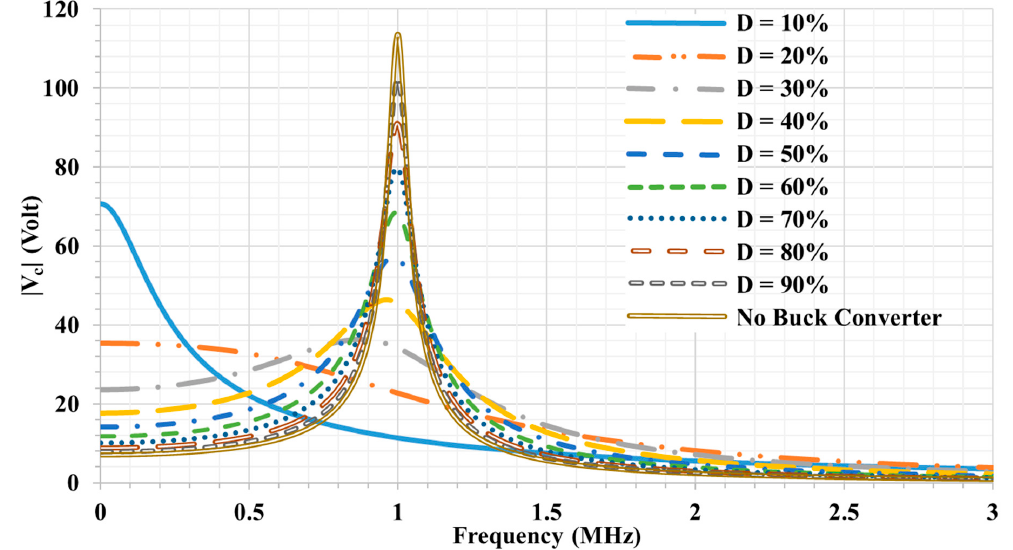
Figure 8. The frequency response of the voltage V c across one pair of the coupling plates at different duty cycles D .